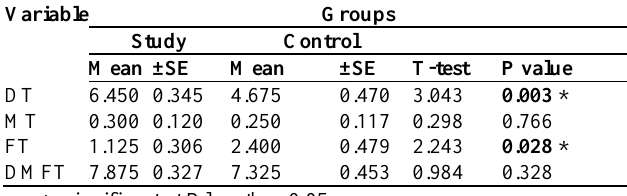
Table 2 : Dental caries experience (DT, MT, FT, and DMFT) (mean ±SE) and statistical difference in the study and control